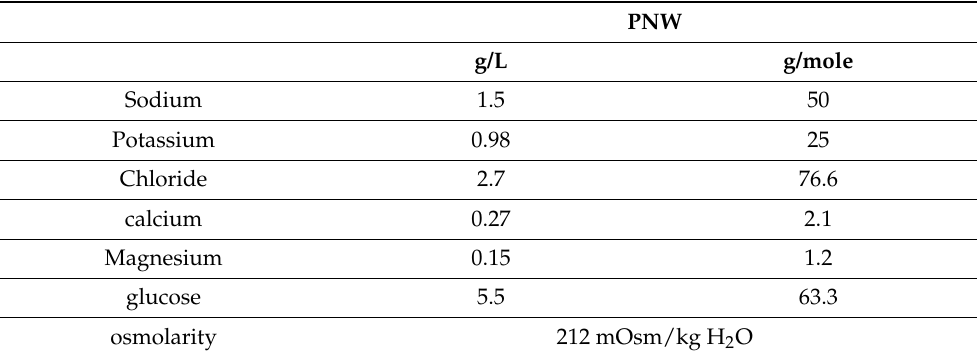
Table 2. The quantity and measured concentrations of the oral electrolyte supplement (PNW) as measured using a blood gas and ion analyzer (Nova Statprofile 5, Nova Biomedical, Waltham, MA, USA). PNW g/L g/mole Sodium 1.5 50 Potassium 0.98 25 Chloride 2.7 76.6 calcium 0.27 2.1 Magnesium 0.15 1.2 glucose 5.5 63.3